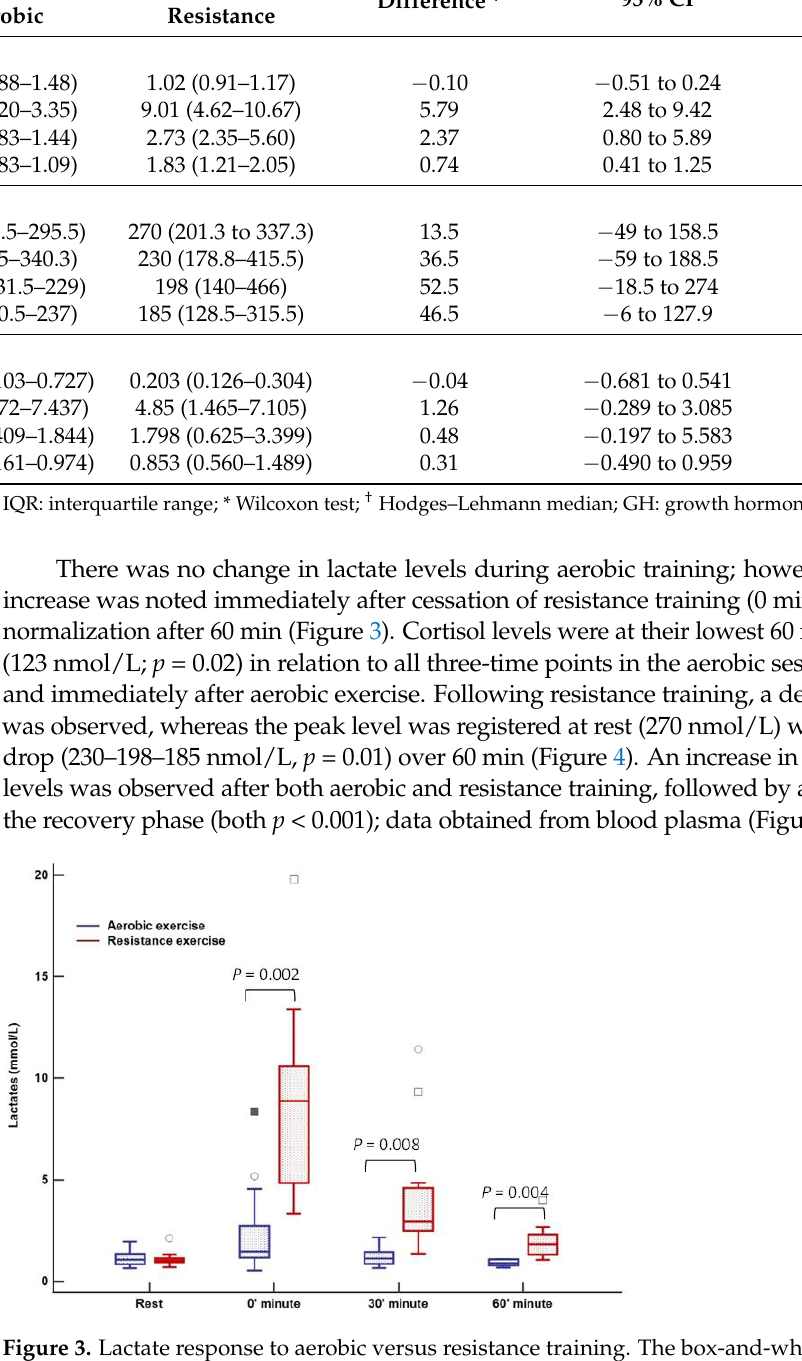
Figure 3. Lactate response to aerobic versus resistance training. The box-and-whisker plot displays the following: the median value (solid line within the box); the interquartile range (2 ends of the box); either the 5th or 95th percentile values or the smallest and largest observations (2 lines with caps extending from the box, the so-called whiskers); and any extreme